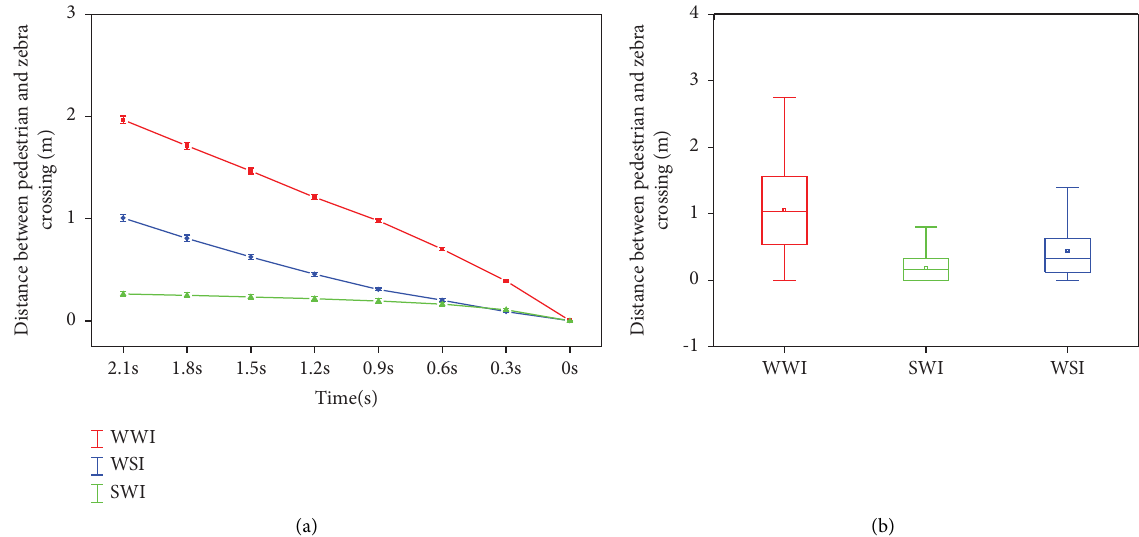
Figure 10: DPZC under diferent crossing intentions. (a) Line chart of DPZC change with time under diferent intentions. (b) Box diagram of DPZC under diferent crossing intentions.